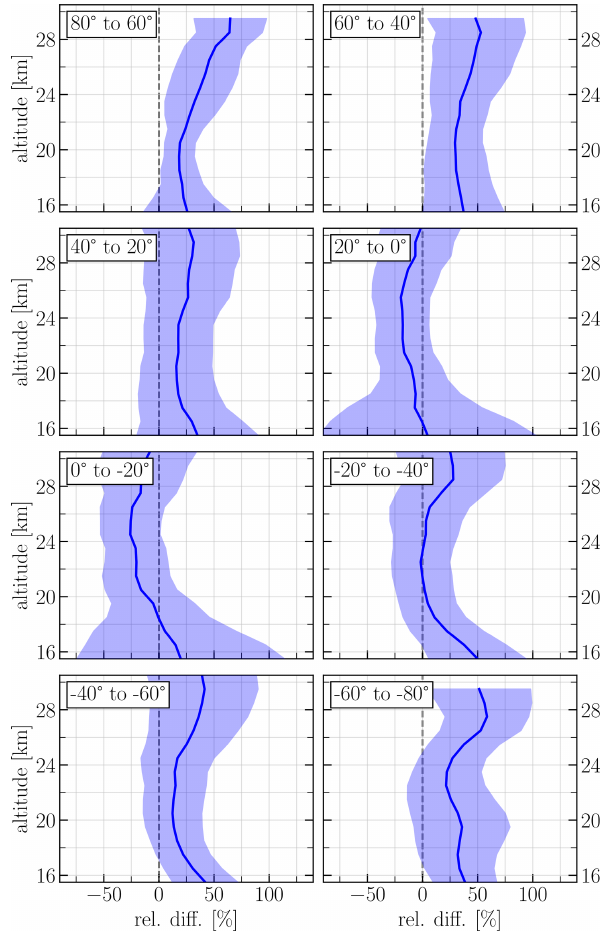
Figure 2. Mean relative difference in Ext 869 between OMPS-LP and SAGE III/ISS calculated as 200 × (OMPS- SAGE)/(OMPS+SAGE). The shaded areas show ± 1 standard